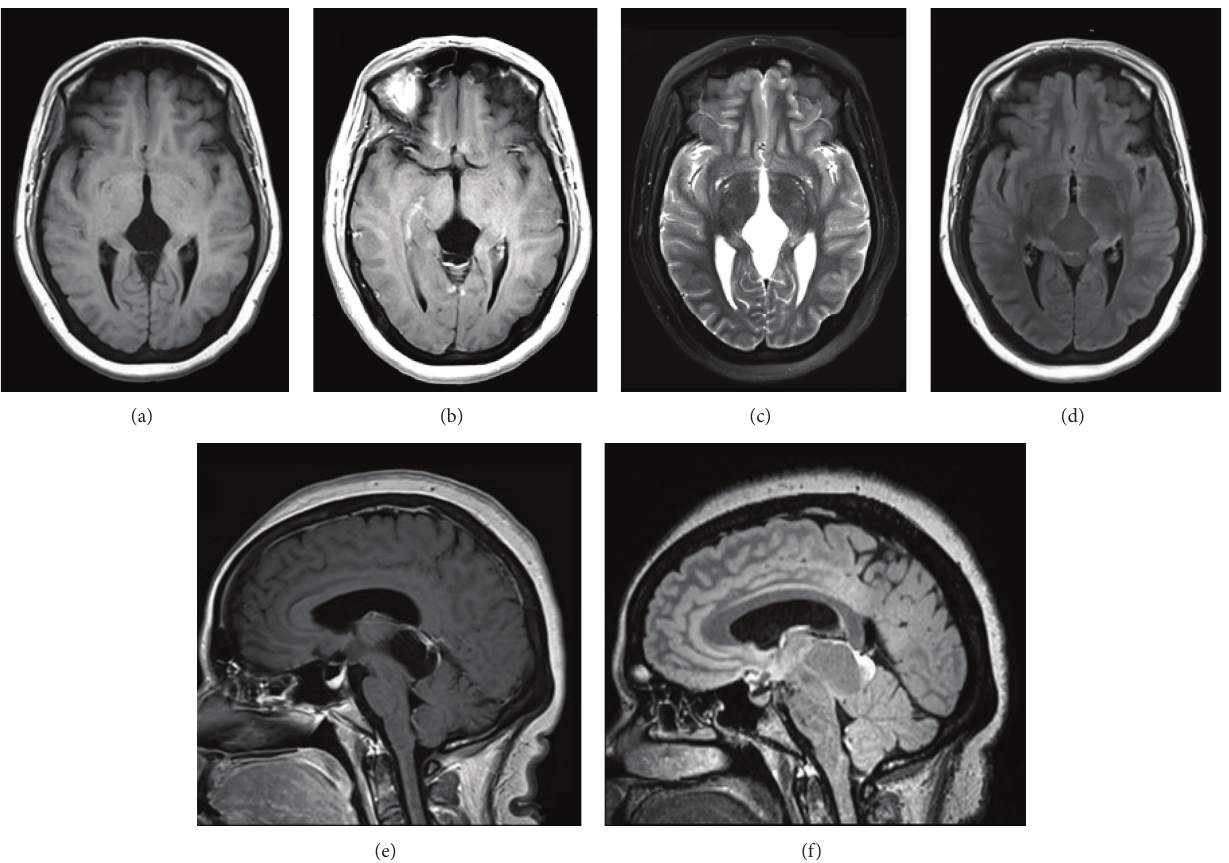
Figure 1: Preoperative MRI findings. Axial T1-weighted image (a) shows a 3.7 × 2.2 × 2.7 cm well-circumscribed complex cystic lesion in the region of the pineal gland, causing significant mass effect on the surrounding structures. There is inferior compression and thinning of the tectal plate, posterior displacement and deformity of the superior cerebellar vermis. T1 postcontrast images ((b) and (e)) show the thin septation posteriorly. There is no enhancement of the cyst wall. On T2-weighted images (c), the signal characteristics are similar to CSF, but the cyst fluid is isointense to slightly hyperintense on FLAIR images ((d) and